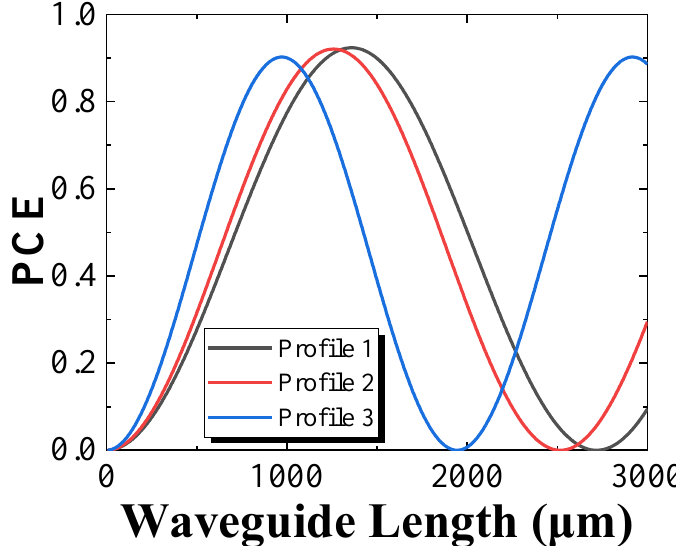
Figure 5. Maximum TE–TM PCE as a function of waveguide width ( W ) and shallow etched depth ( D 1 ) from ( a ) broad-range optimization and ( b ) narrow-range optimization. Table 2. Three profiles of waveguide parameters.